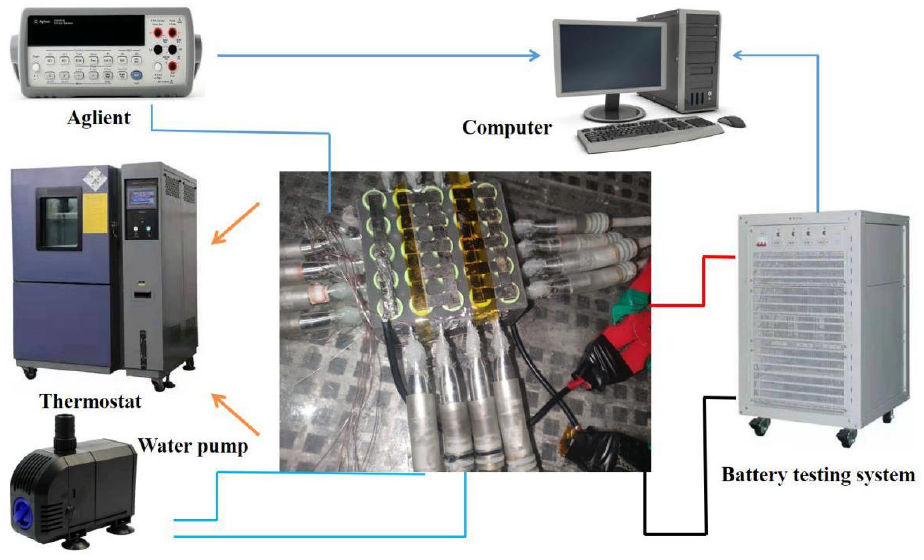
Table 1. The parameters of the prismatic LIBs in the simulation.